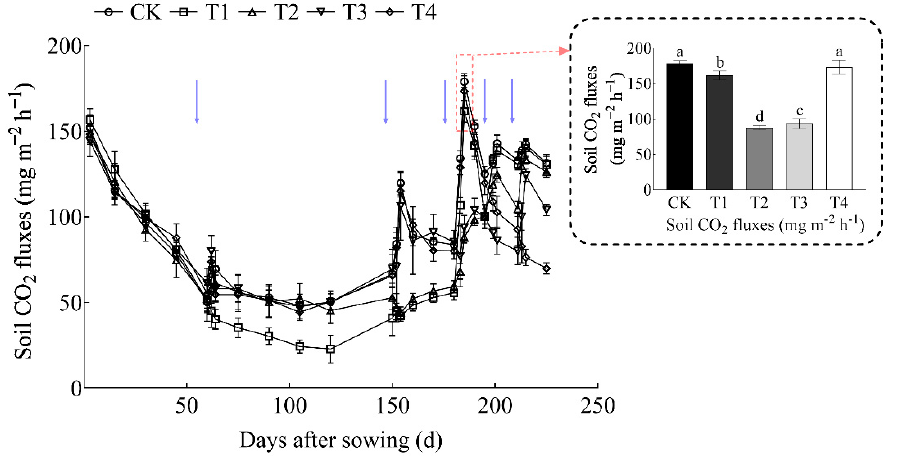
Figure 2. Changes in soil CO 2 fluxes (mg m − 2 h − 1 ) under different irrigation treatments during a winter wheat growing season. The blue arrows denote irrigation; vertical bars represent standard errors (SE, n = 3). Different lowercase letters show that the mean values are significant based on LSD multiple range tests at p < 0.05.